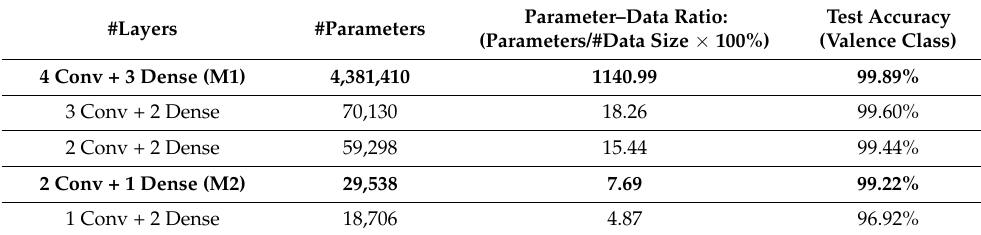
Table 7. Selecting the most optimal 1D CNN